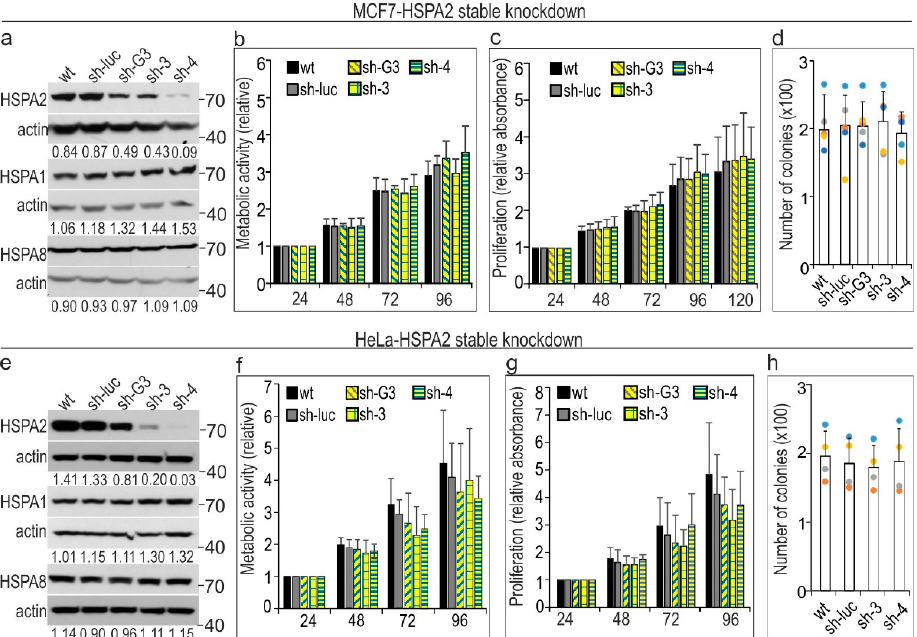
Figure 6. Stable shRNA-mediated HSPA2 silencing in ( a – d ) breast luminal-A type carcinoma MCF7 cells and ( e – h ) human cervical adenocarcinoma HeLa cells. Immunoblots ( a , e ) show protein levels of HSPA2, HSPA1, and HSPA8 in wild type (wt); control sh-luc cells transduced with the non-targeting shRNA-luc sequence; sh-G3, sh-3, and sh-4 cells stably transduced with HSPA2 -targeting shRNAG3, shRNA3, or shRNA4 sequences, respectively. The numbers below each lane represent the protein ratio normalized to the actin level. Representative immunoblots are shown (HeLa, n = 5; MCF7, n = 4), and actin was used as a protein loading control. Cell metabolic activity ( b , f ) was tested using the MTS assay. Results are expressed as mean ± SD ( n = 5, each in three technical replicas) in relation to values obtained at 24 h after plating ( b , f ). The cell proliferation rate ( c , g ) was examined using crystal violet staining assay ( n = 5; each in three technical replicas). For the clonogenic assay ( d , h ), cells were plated onto six-well dishes (HeLa 1 × 10 3 cells / well, MCF7 3 × 10 3 cells / well) and cultured for 7 days. Colonies were counted manually (mean ± SD, HeLa n = 4, each in three technical replicas, MCF7 n = 7, each in 2–3 technical replicas). Each dot color represents results of one of seven ( d ) or four ( h ) independent experiments.